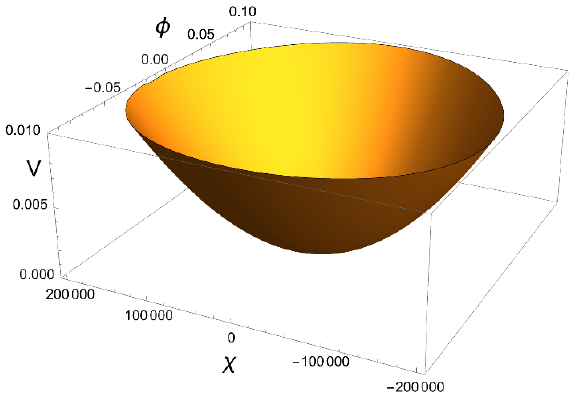
Figure 2 . The scalar potential for (cid:30) and (cid:31) with wide (cid:12)eld range for (cid:31) and narrow for (cid:30) .